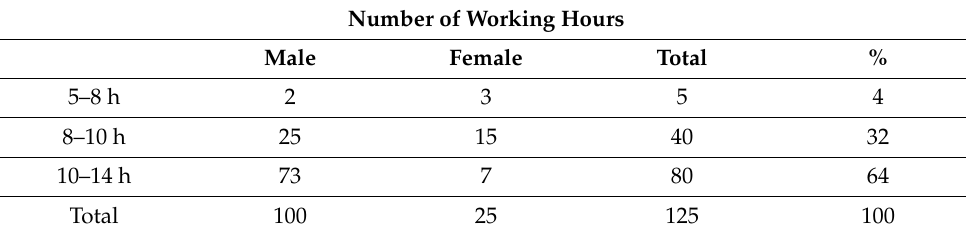
Table 5. Earnings of waste pickers in Lagos State, Nigeria.